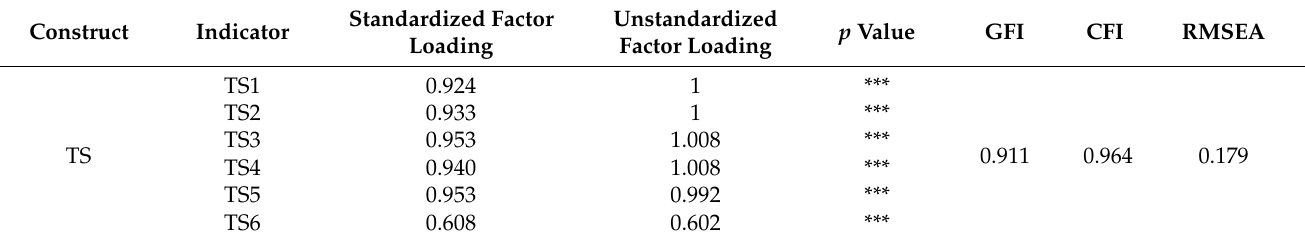
Table 5. CFA of perceived